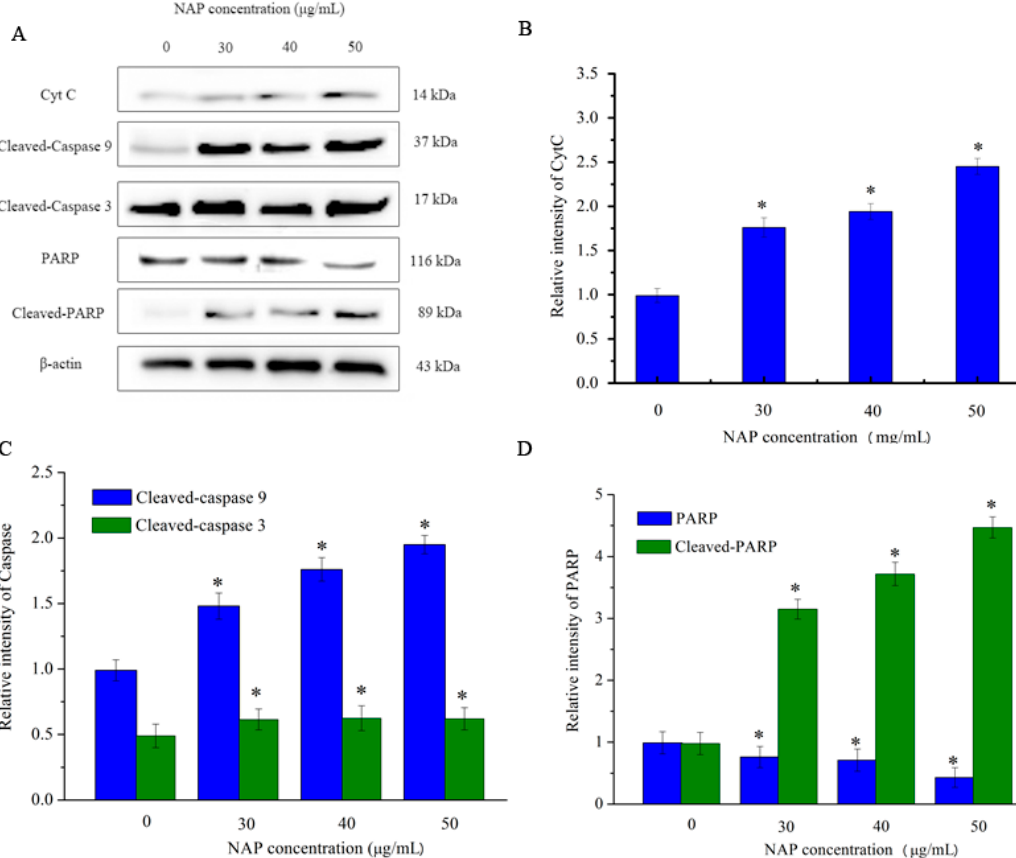
Figure 7. Expression of other apoptosis-associated proteins in H1299 cells treated with NAP for 24 h. H1299 cells were treated with 0, 30, 40 and 50 μ g/mL NAP for 24 h and cells were harvested to measure ( A ) Western blotting of CytC, cleaved-caspase 9, cleaved-caspase 3, PARP, and cleaved-PARP protein; ( B ) Protein expression level of CytC that expressed in the treated-H1299 cells; ( C ) Protein expression level of cleaved-caspase 9 and cleaved-caspase 3 that expressed in the treated-H1299 cells ( D ) Protein expression level of PARP and cleaved-PARP that expressed in the treated-H1299 cells. The blots were also probed with β -actin antibodies to confirm equal sample loading. The blots were detected with β -actin antibody to determine equal sample loading. * p < 0.05 vs. control.